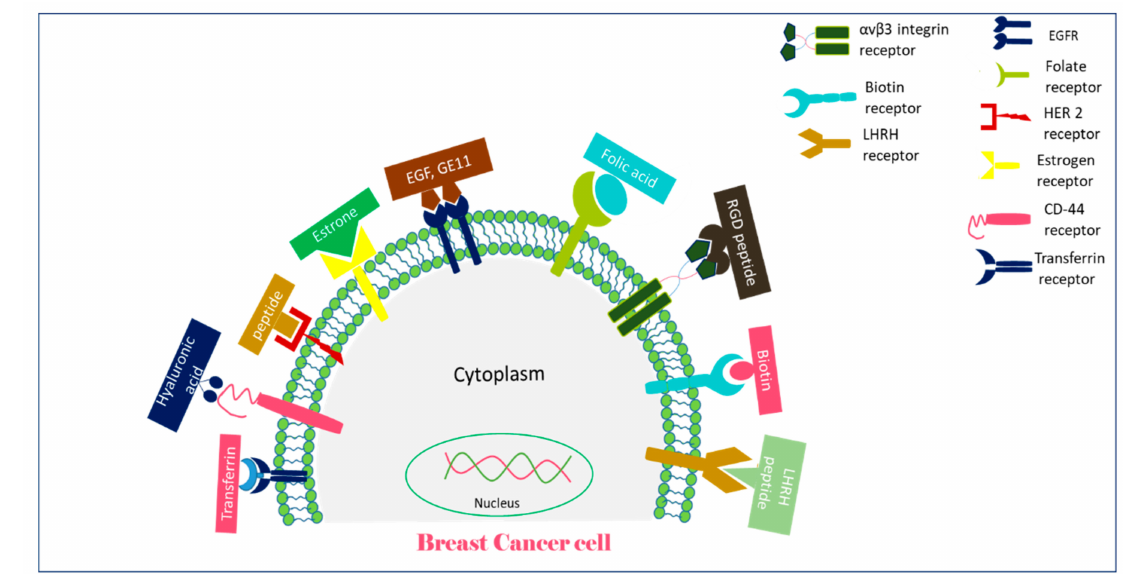
Figure 1. A schematic representation of receptors overexpressed on breast cancer cells and their targeting moieties for targeted breast cancer therapy.